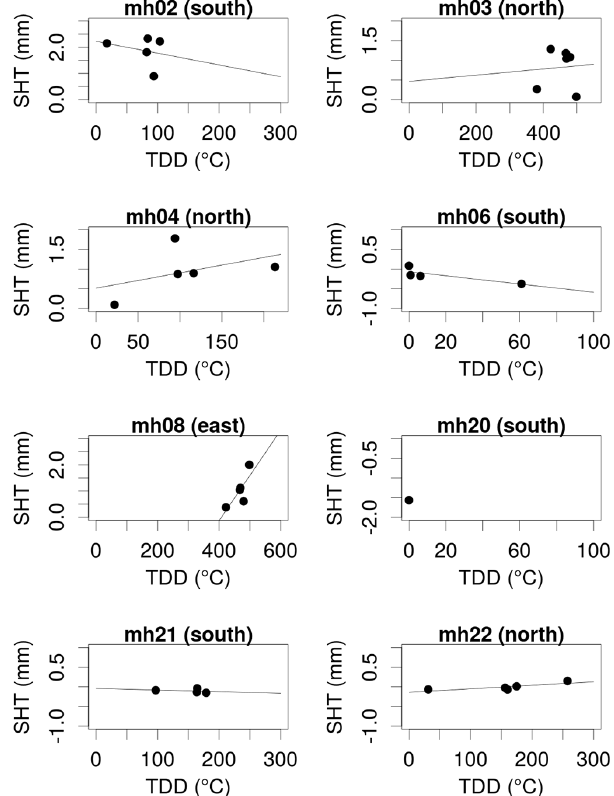
Figure A3. Summer shift (SHT summer ) of displacement perpendic- ular to fracture against yearly thawing degree days (TDD year ) for locations mh02 , mh03 , mh04 , mh08 , mh21 and mh22 . The black line indicates the regression